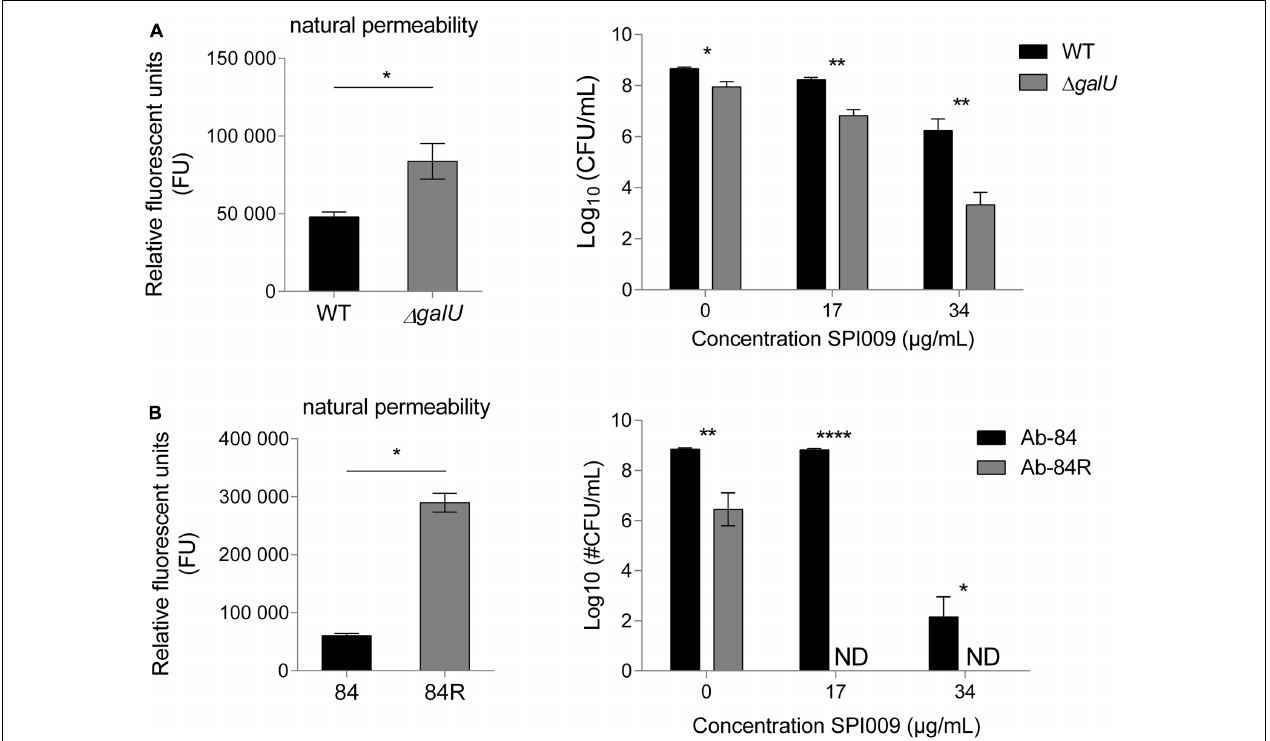
FIGURE 9 | Cells displaying increased membrane permeability show higher sensitivity toward SPI009. Mutants resulting in LPS biosynthesis malfunction or complete loss of the LPS layer were selected for (A) P. aeruginosa and (B) Acinetobacter baumannii , respectively. Natural membrane permeability was assessed by means of NPN assays of untreated cultures (left panel). Statistical analysis was done by means of a single unpaired, two-tailed t -test ( α = 0.05). Next, stationary phase cultures of WT and mutant strains were treated for 5 h with increasing concentrations of SPI009 (right panel). Statistical analysis was done by means of multiple t -tests ( α = 0.05) to compare the antibacterial effect of SPI009 between the WT and mutant strain, with Holm–Sidak correction for multiple testing. Displayed data points show the average of at least three independent repeats ± SEM. ∗ P < 0.05; ∗∗ P < 0.01; ∗∗∗ P < 0.001; and ∗∗∗∗ P ≤ 0.0001; ND, not